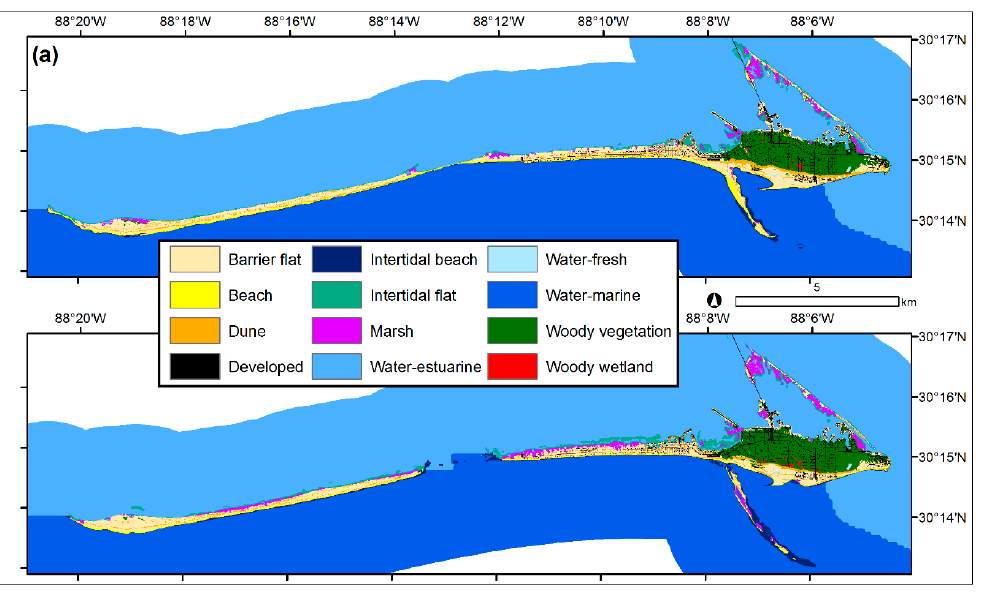
Figure 9. Final habitat model prediction maps for the barrier island for Dauphin Island, Alabama, USA. ( a ) Final contemporary model (i.e., 2015). ( b ) Final hindcast model (i.e., 2007 for most of the island and 2002 to for the northeast portion of the island). Table 3. Error matrix with deterministic and fuzzy accuracies for the hindcast model results (i.e., with post-processing and a four-pixel minimum mapping unit) for Dauphin Island, Alabama, USA. For the o ff -diagonal cells, the first value indicates deterministic count and the second value indicates the fuzzy count. BF: Barrier flat; B: Beach; CT: Column total; D: Dune; DPA: Deterministic